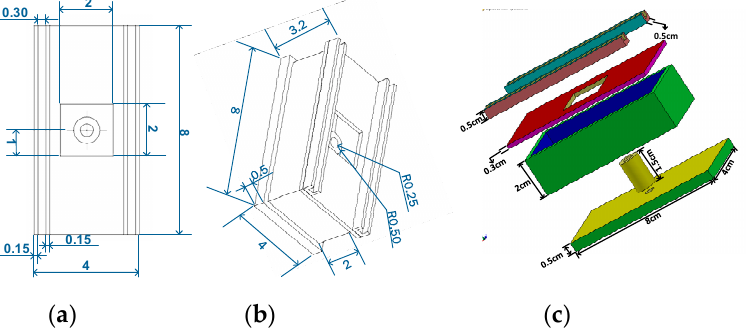
Figure 3. Dimension of custom-built sample chamber printed with 3D printer which houses detector circuitry (CR-10): ( a ) top view, ( b ) isometric view, and ( c ) 3-dimensional view (exploded). All dimensions in this figure are given in cm.